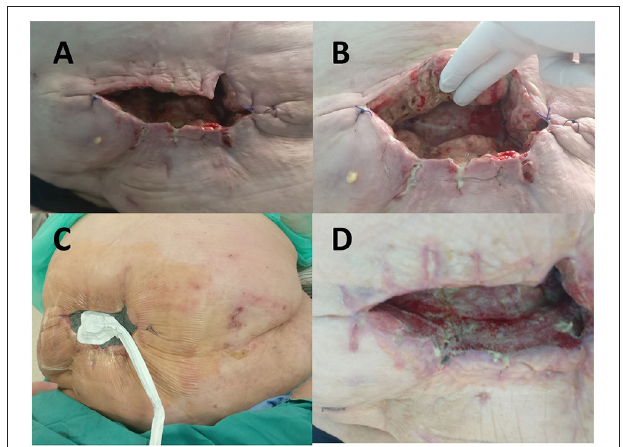
FIGURE 2 | (A) Wound dehiscence on the 4th postoperative day after necrectomy with primary closure. (B) Fibrin deposits with zones of the necrotic tissue in the wound. (C) Negative pressure wound therapy delivered in continuous mode with negative pressure maintained at − 100mm Hg was initiated on the 33rd postoperative day. (D) View of the wound 2 weeks after negative pressure wound therapy (NPWT) administration with signs of considerable improvement seen in cavity reduction, decreased wound discharge, and formation of healthy granulation